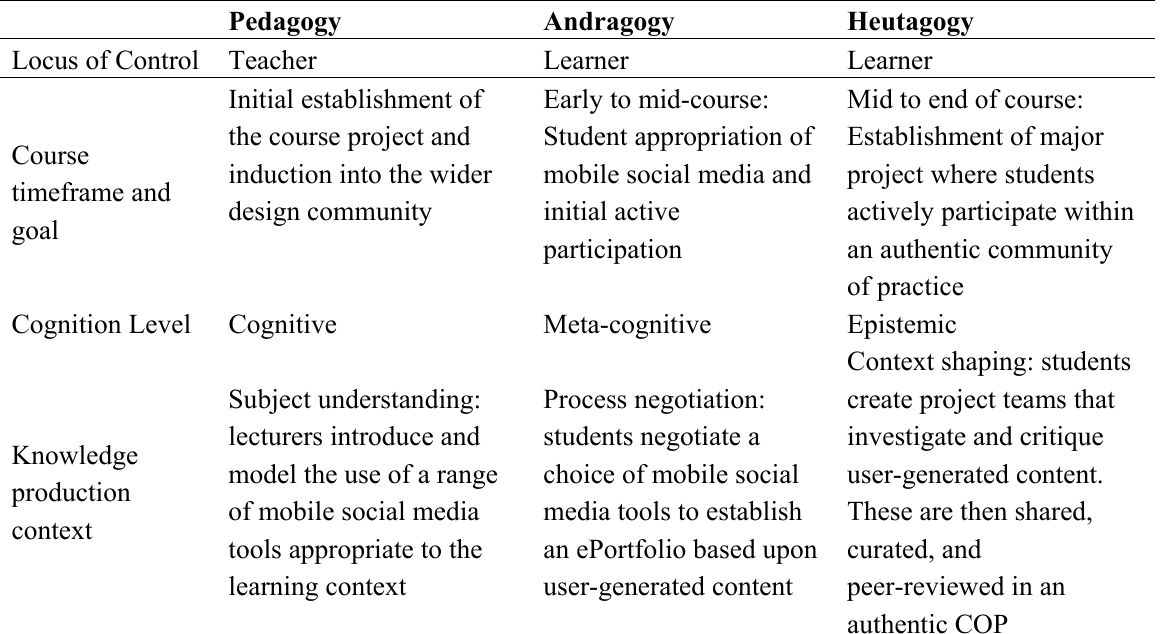
Table 3. A framework for using mobile social media to enable a move towards heutagogy (modified from